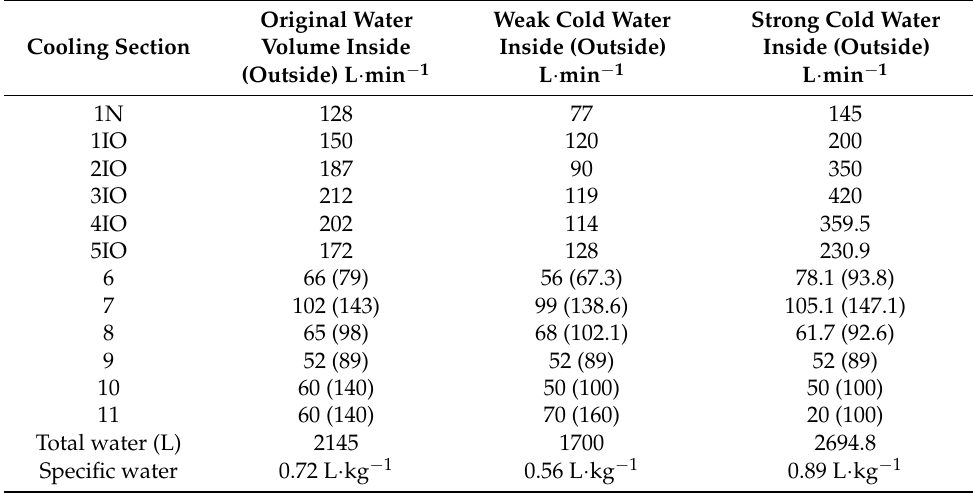
Table 4. Adjustment scheme of the secondary cooling water